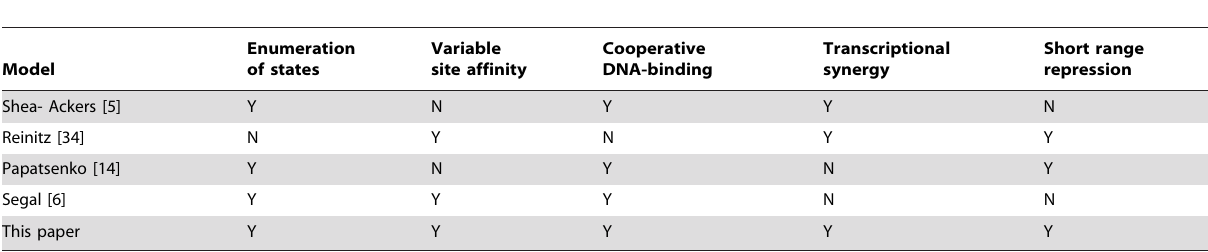
Table 1. Thermodynamics-based models of gene expression and their properties.